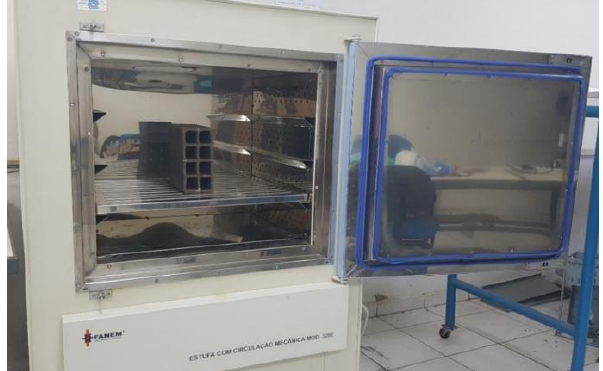
Figure 1. Ceramic brick in the oven.